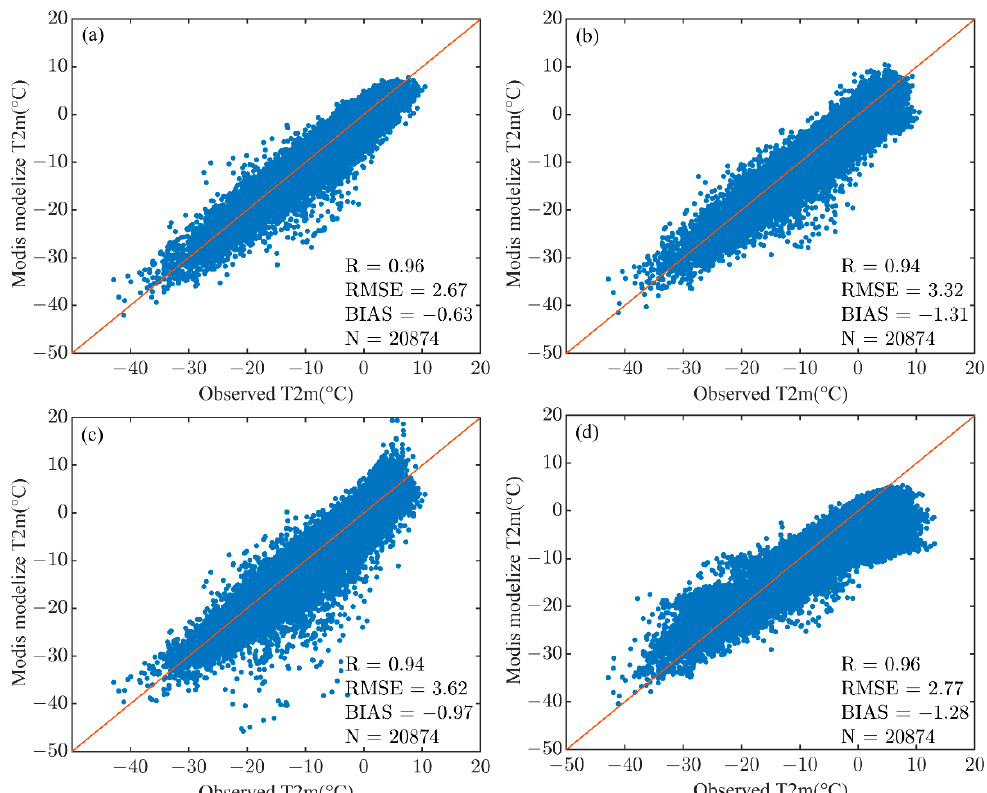
Figure 5. Comparison of reconstruction results of NN ( a ), GPR ( b ), SVM ( c ), and RF ( d ) against the observed T2m. R, correlation coefficient; RMSE (°C), root mean square error; BIAS (°C), mean difference; and N, number of samples.